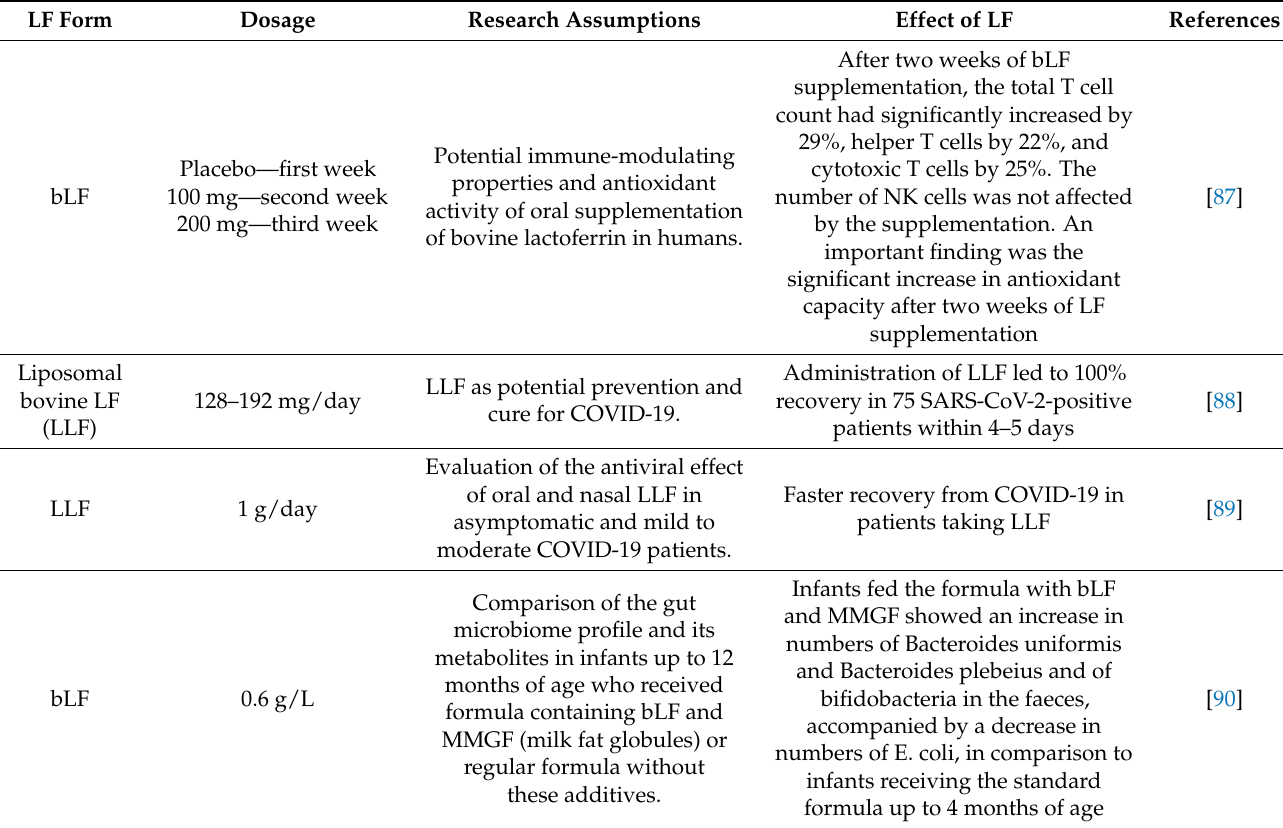
Table 3. Effect of LF supplementation on the immune system (own